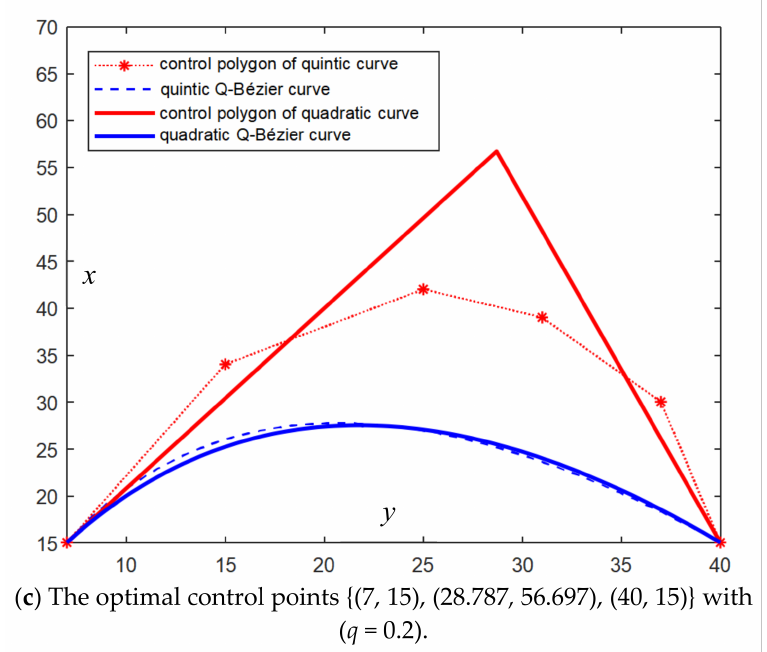
Figure 5. Three-degree reduction of a quartic Q-B é zier curve with the shape parameter q = 1, 0.5, 0.2. Example 5. Figure 6 shows the five-degree reduction of a Q-B é zier curve of degree 7, whose control points are { T 0 = (5, 5), T 1 = (10, 15), T 2 = (15, 20), T 3 = (20, 35), T 4 = (25, 30), T 5 = (35, 28), T 6 = (40, 20), T 7 = (50, 5)}. With q = 1, the original Q-B é zier curve of degree 7 (blue dot line) and the approximating Q-B é zier curve of degree 2 (blue solid line) are shown in Figure 6a. Another pair of curves with q = 0.5 is displayed in Figure 6b. Analogously, the change of the shape parameter q will slightly affect the effect of the five-degree reduction of the Q-B é zier curves, which is consistent with the conclusion in Example 4. However, the shapes of the control polygon for the approximating curves change significantly with the change of the shape parameter q.